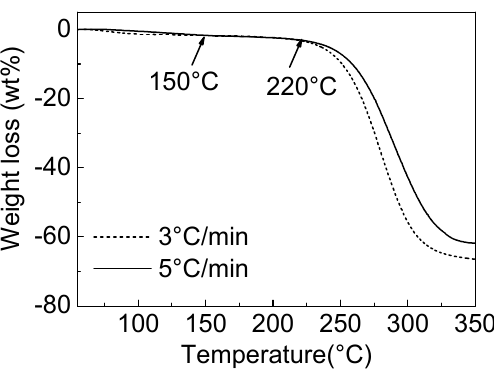
Figure 5. The TGA profiles of the CPVC spun fibres, under air flow with different heating rates.